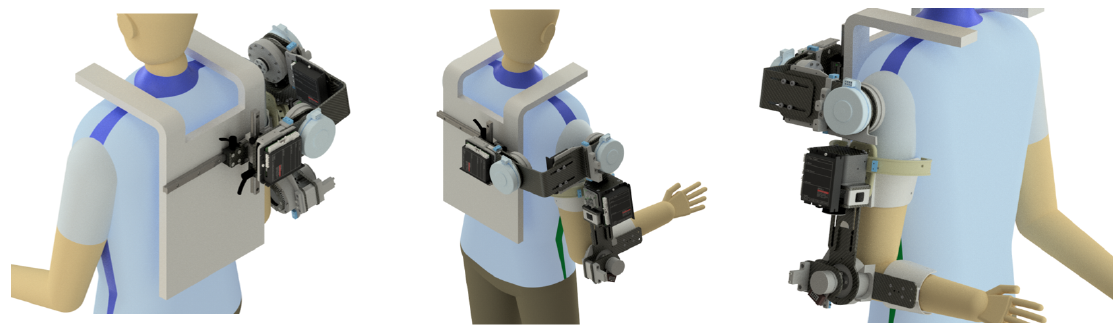
Figure 5. Upper-limb exoskeleton